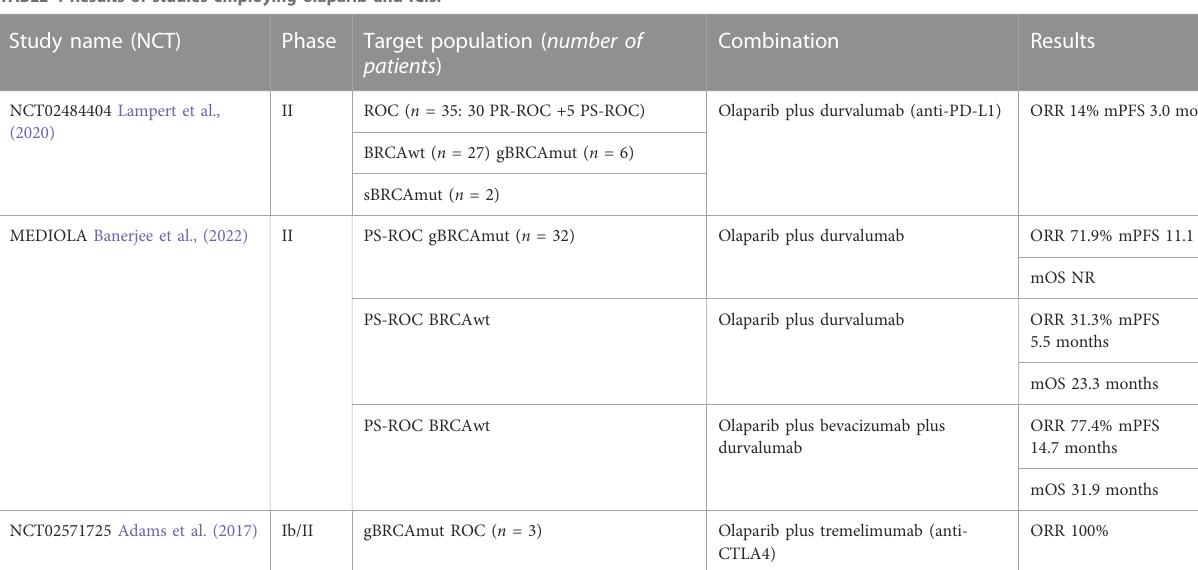
TABLE 4 Results of studies employing olaparib and